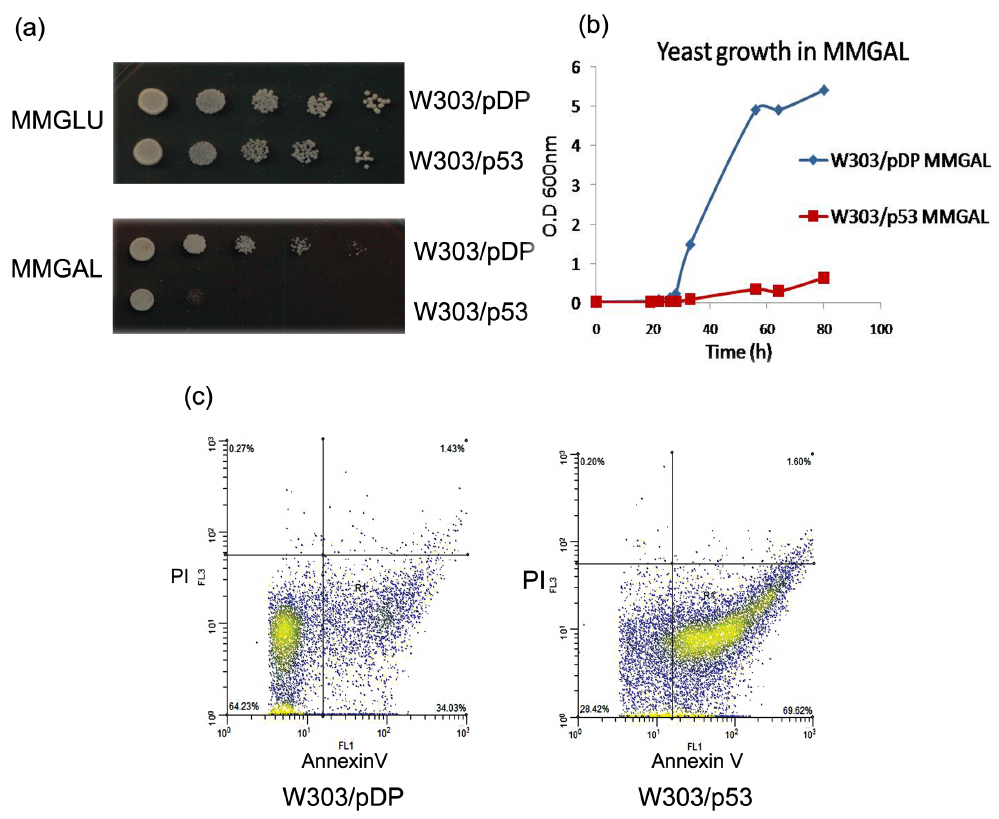
Fig 1. Effect of p53 expression on yeast growth of the recombinant yeast clones W303/pDP and W303/p53. (a) Recombinantyeast clones W303/pDP and W303/p53 growth on solid (MMGLU media serves as a control of cell number) and (b) on liquidmedia. (c) flow cytometric analysisof the phosphatidylserines externalization by FITC-Annexin V/PI costainedW303/pDP and